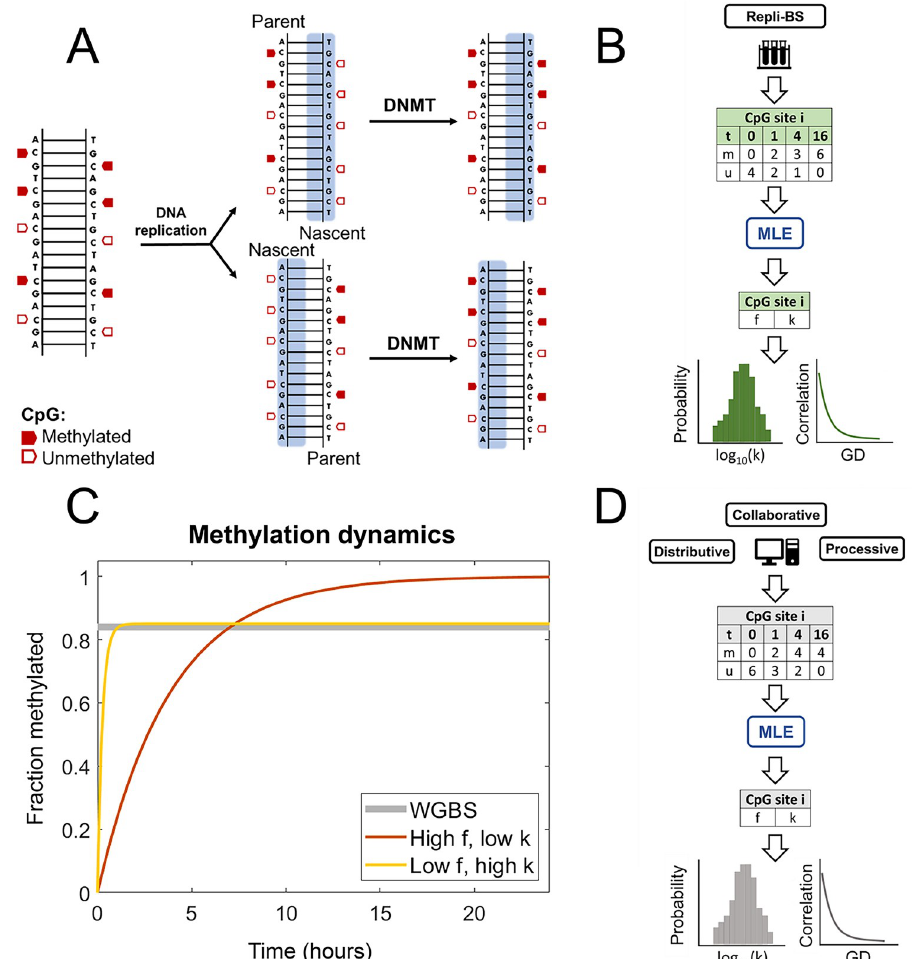
Fig 1. A : DNA methylation in the context of replication. Upon replication, complementary unmethylated nascent strands are synthesized for each parent strand, such that fully methylated CpGs become hemimethylated. Classically, full methylation is restored by DNMT1 (though DNMT3s have also been shown to contribute to this maintenance). B : Work-flow of the data analysis: Repli-BS data records methylated (m) and unmethylated (u) reads on the nascent strand for each site i genome-wide, with timepoints over 16 hours. MLE allows the inference of stochastic model parameters for each site i , giving outputs of parameter distributions and parameter-correlation with genomic distance (GD). C : The MLE procedure assesses remethylation rate ( k ) and steady-state remethylation fraction ( f ) for each CpG site, thus distinguishing between sites that are remethylated faster while reaching a lower average methylation level (yellow line) and sites with slower kinetics but higher methylation overall (orange line). In contrast, traditional WGBS would not distinguish these cases, as they have roughly the same time-average (grey line). D : Work-flow of the enzyme-kinetic simulations: Stochastic modeling of remethylation kinetics according to either a Distributive, Processive, or Collaborative mechanism generates simulated datasets, which are then analyzed with the same MLE procedure used for the experimental data, shedding light on in vivo